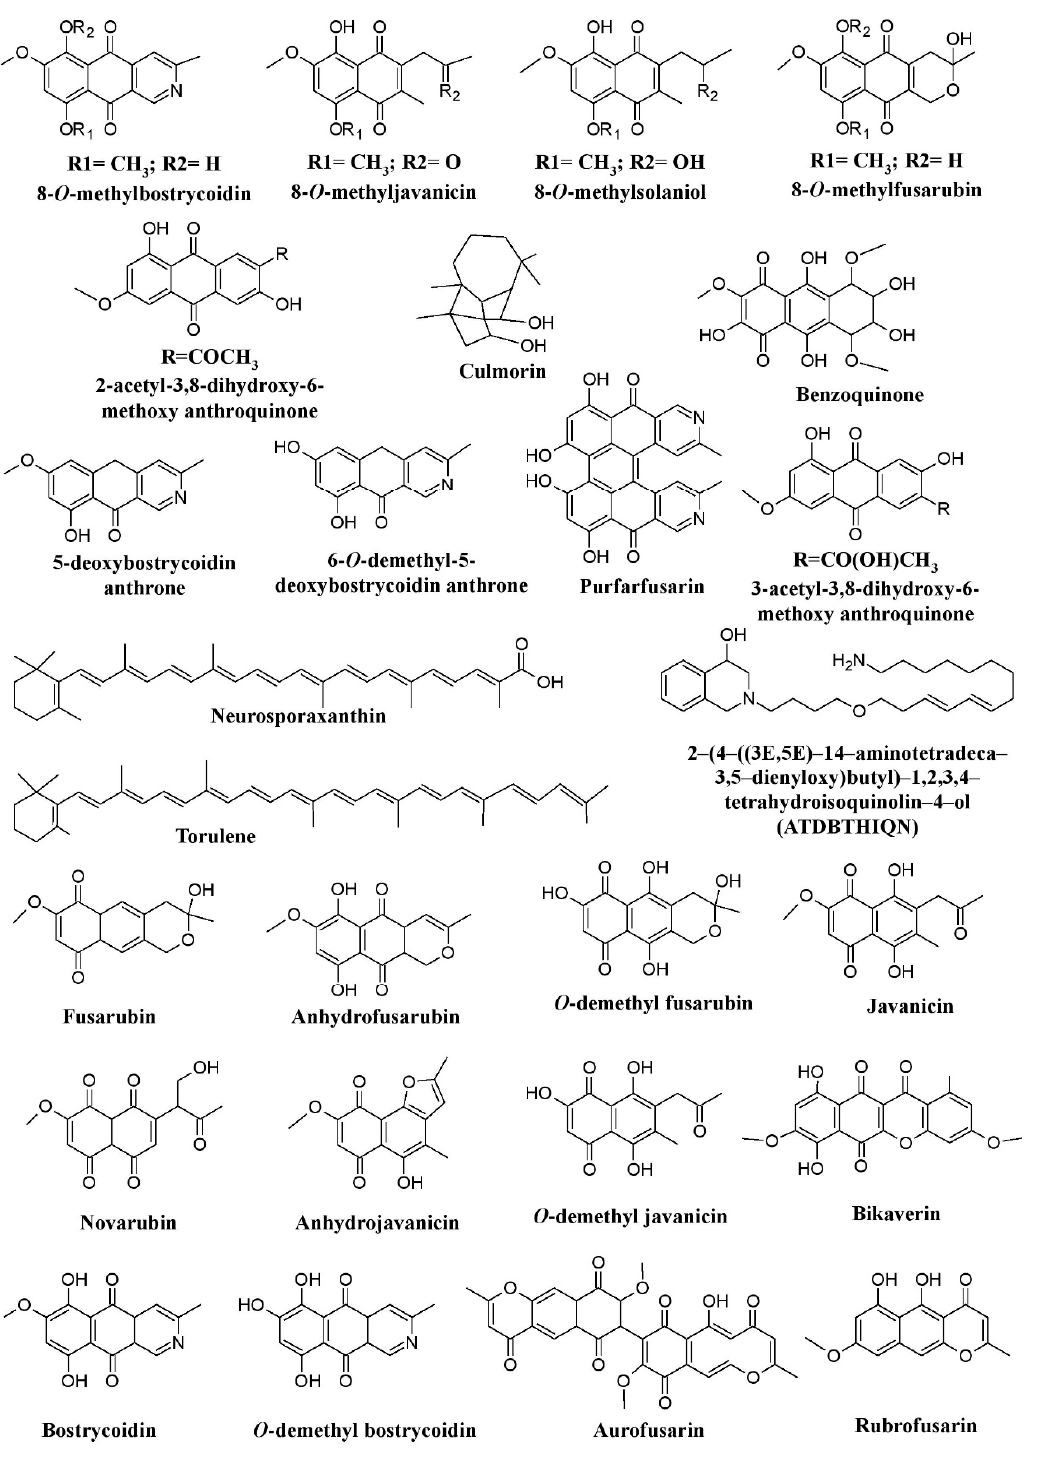
Figure 2. Pigments from fungal genera of Nectriaceae ( Fusarium , Fusicolla , and Albonectria ), re-drawn from [25,47,63,65,66,68].